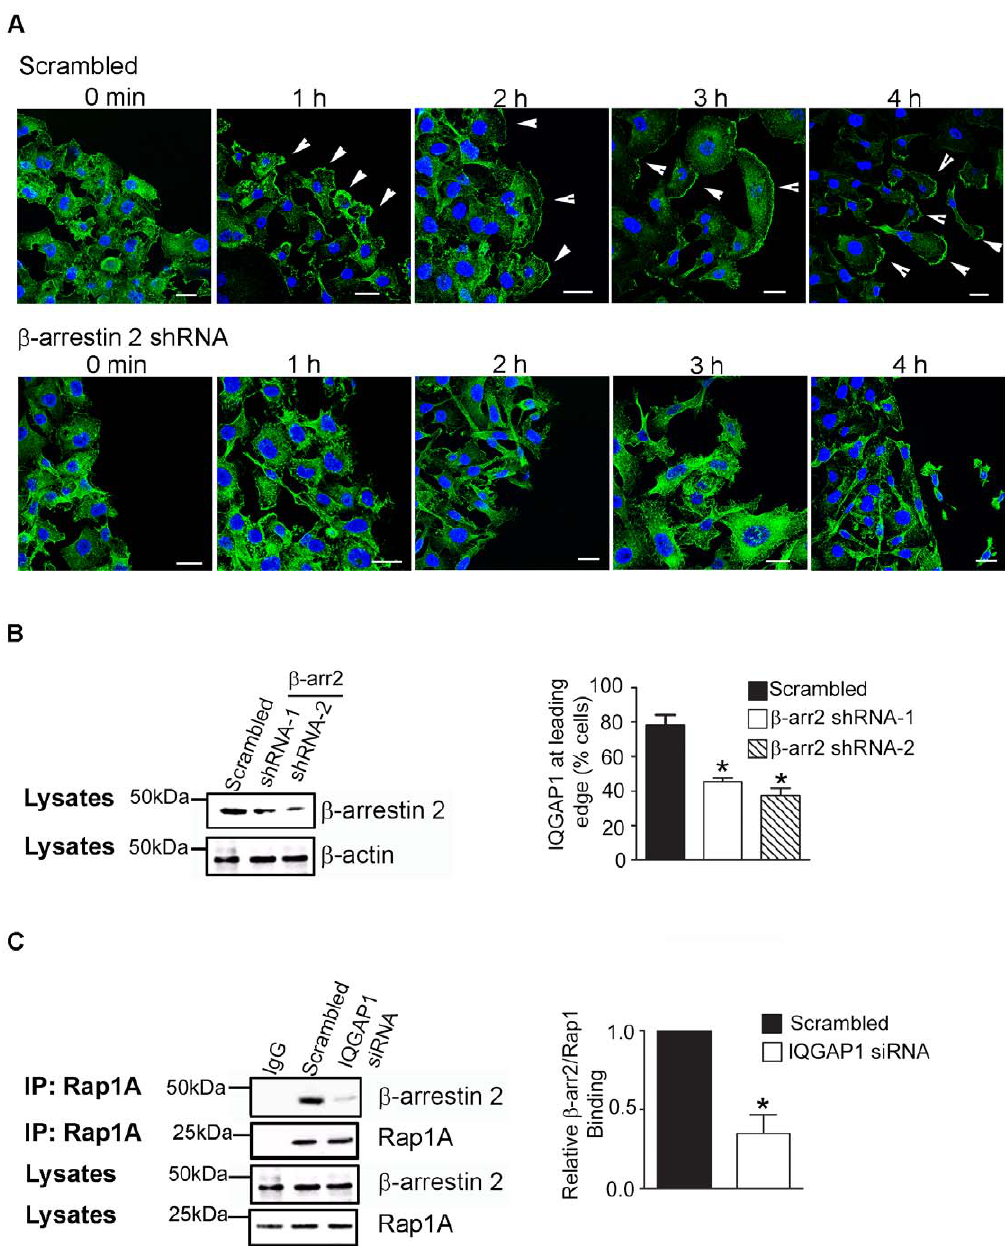
Figure 8. b -arrestin2 regulates LPA-stimulated localization of IQGAP1 to the leading edge. (A) MDA-MB-231 cells were serum starved for 4h and scratched with a sterile pipette tip. Cells were then placed in serum-free medium containing 10 m M LPA and allowed to migrate into the scratch. Cells were fixed, permeabilized, immunostained and visualized using confocal microscopy. LPA (10 m M) stimulates lamellipodia formation and the accumulation of IQGAP1 at the leading edge of motile MDA-MB-231cells (white arrowheads) expressing scrambled shRNA (control, upper panel) in a scratch assay. The effect of depleting endogenous b -arrestin2 from LPA-stimulated cells is shown (lower panel). Endogenous IQGAP1 immunostaining was performed with rabbit anti-IQGAP1 antibody followed by Alexa-Fluor 488 (green). Scale bar, 20 m m. (B) b -arrestin2 expression in MDA-MB-231 cells stably expressing shRNA against b -arrestin2 was verified by Western blot analysis. A representative blot from three independent experiments is shown. Graph showing blind quantification of cells containing IQGAP1 at the leading edge of migrating cells from (A) carried out after stimulation of cells with LPA for 4 hours, as described under ‘‘Experimental Procedures’’. Error bar, SEM *, p , 0.05. Data from three independent experiments. (C) Depletion of IQGAP1 blocks the endogenous association of Rap1A and b -arrestin2 in MDA-MB-231 cells. Co-immunoprecipitation studies were performed using a rabbit polyclonal anti-Rap1A antibody. Endogenous b -arrestin2 was detected with a monoclonal anti- b -arrestin2 antibody. A representative blot from three independent experiments.